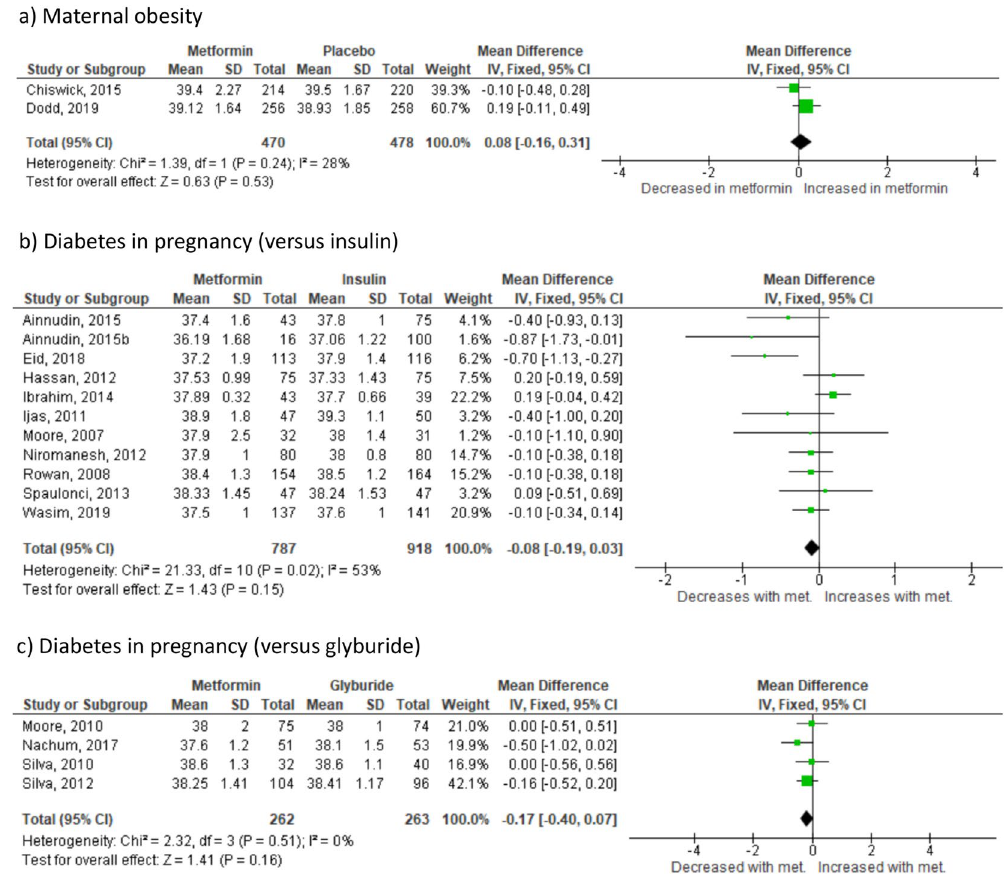
Figure 5. Effect of metformin randomisation upon gestational age at delivery (all indications), (based on 18 studies including 3818 pregnancies). Odds ratio (95% CI), random-effects